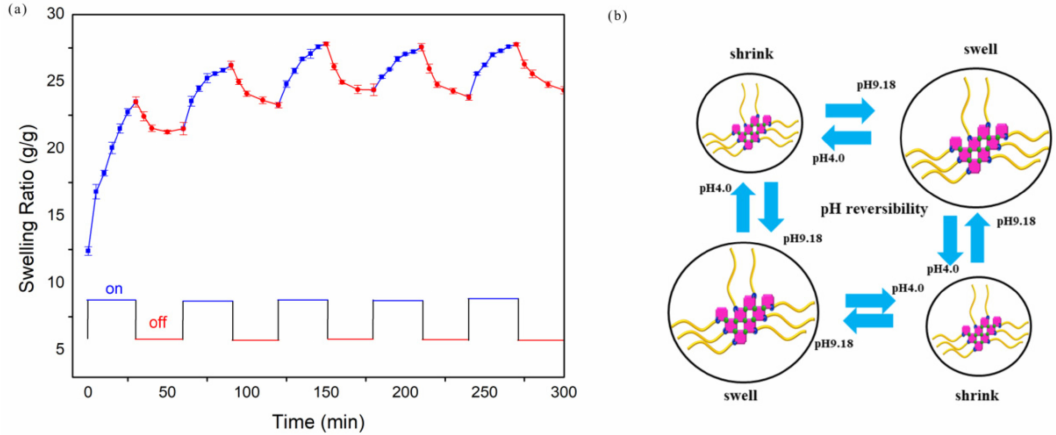
Figure 7. ( a ) On-o ff switching behavior as reversible pulsatile swelling (pH 9.18) and deswelling (pH 4.0) of GNCH. The time interval between pH changes is 30 min; ( b ) Mechanism of pH reversible